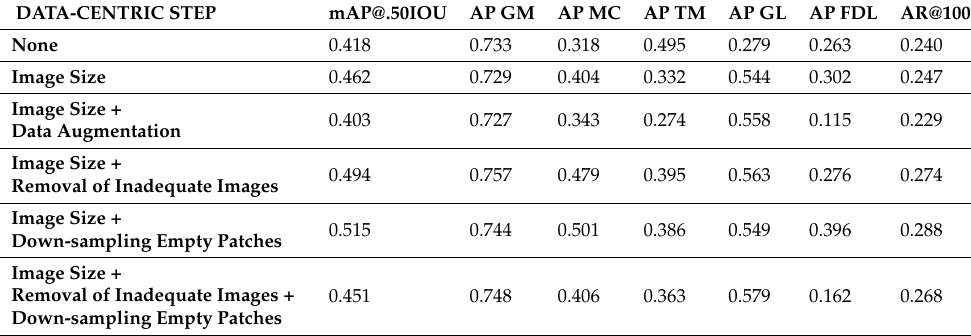
Table 4. Data-centric results for SSD ResNet50.